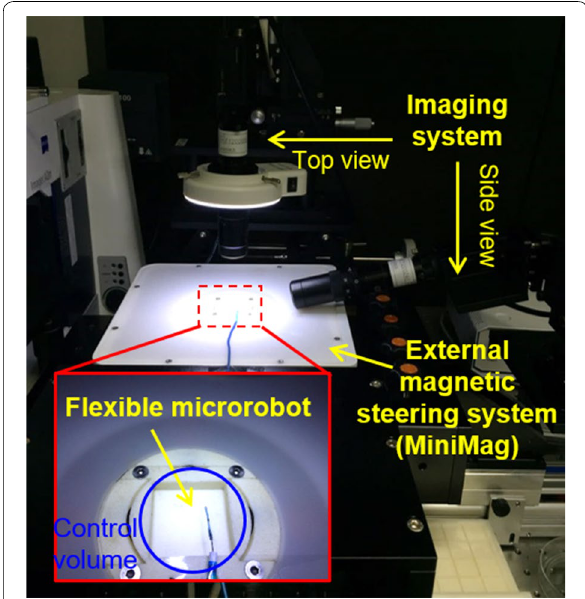
Fig. 5 Experimental setup used to test steering and tracking of the flexible microrobot using a magnetic coil system (MiniMag)